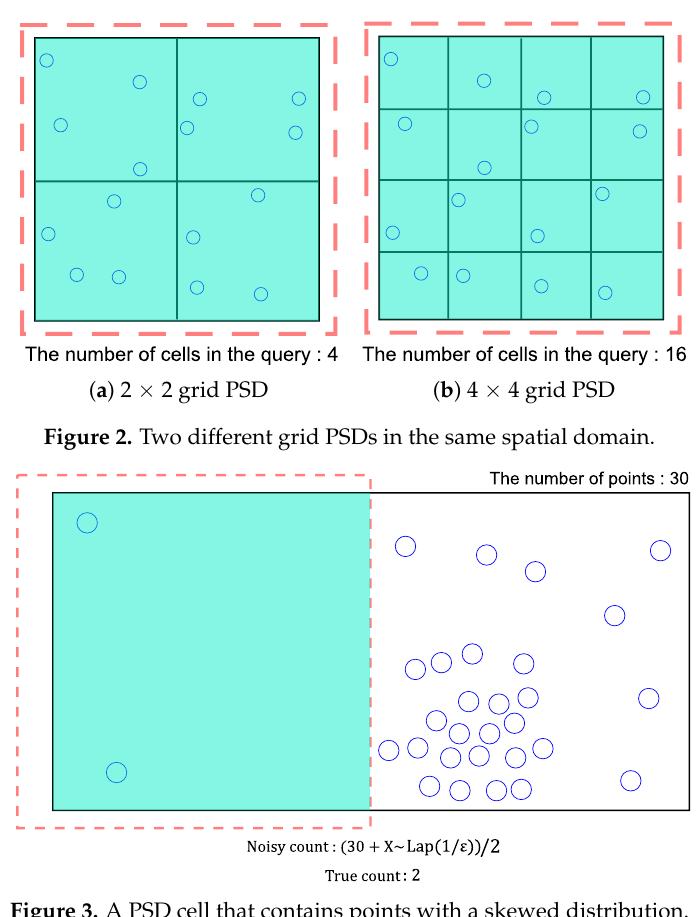
Figure 3. A PSD cell that contains points with a skewed